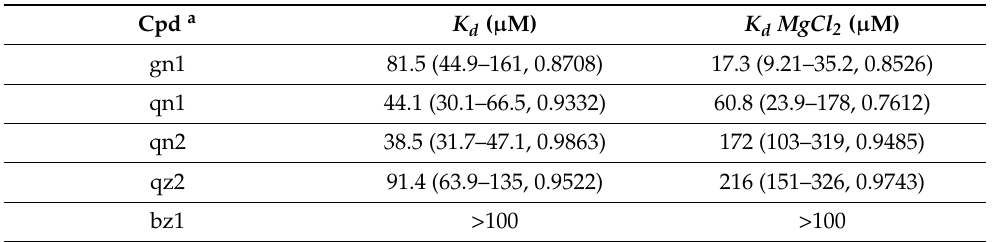
Table 2. IIa h interaction parameters of pharmacophore hits measured by fluorescence intensity